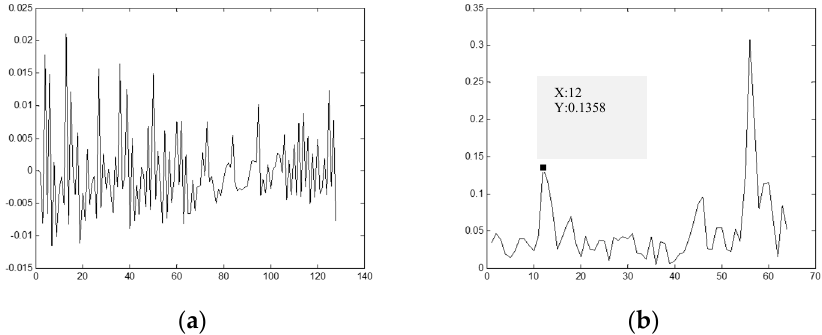
Figure 15. Mechanical signal recognized as picking signal. ( a ) Time domain; ( b ) Frequency domain. Algorithms 2018 , 11 , x FOR PEER REVIEW